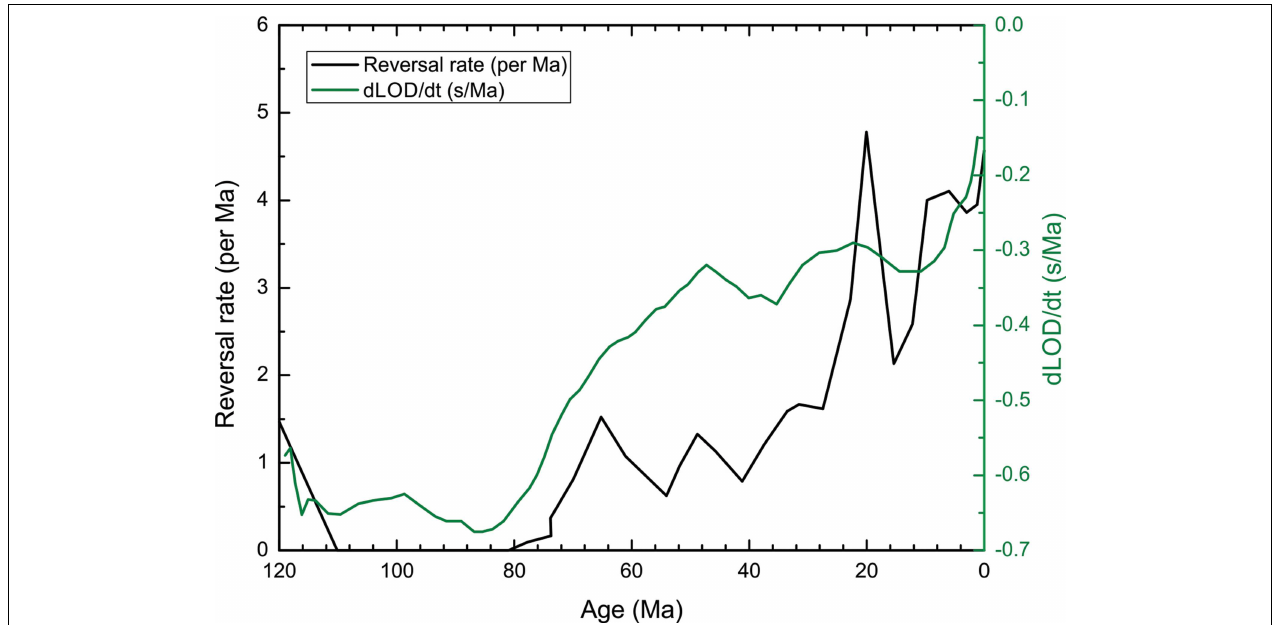
FIGURE 1 | Geomagnetic reversal rates over the past 120 Ma period, which were calculated according to Pavlov and Gallet (2005) and compared with the LOD time derivative variations from Greff-Lefftz